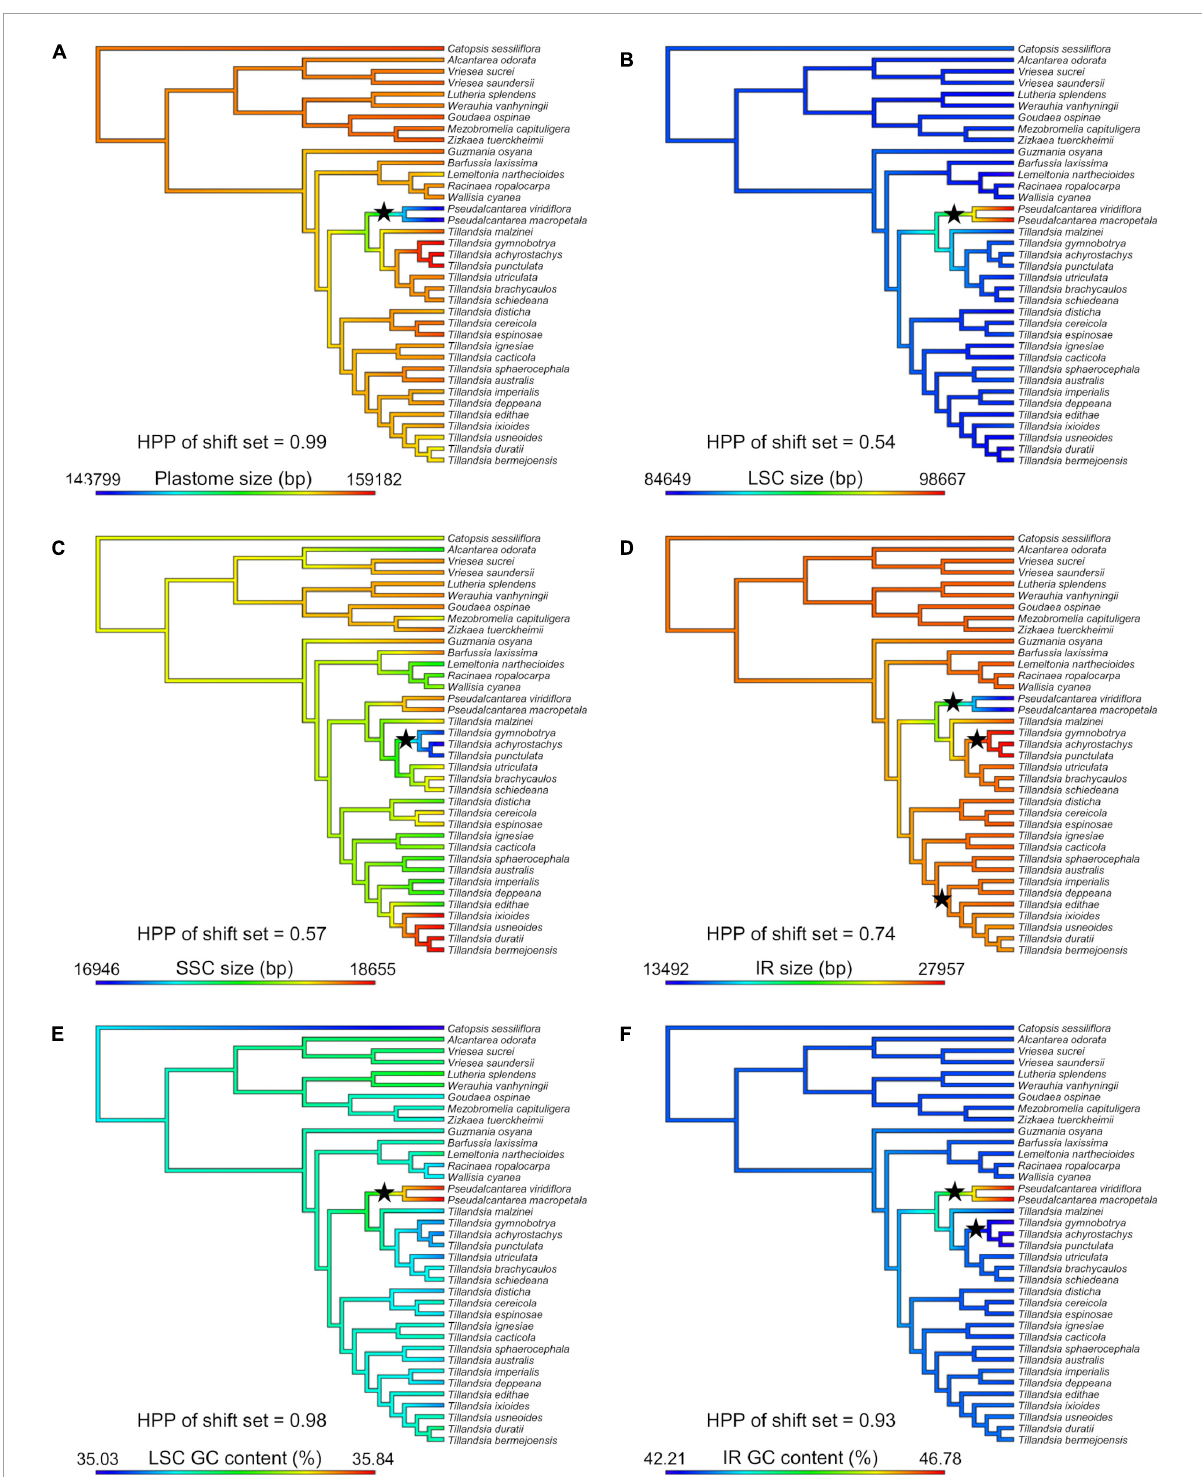
FIGURE3 Evolution of six plastome attributes where evolutionary rate shift sets were detected by BAMM with PP ≥ 0.5. Ancestral state reconstruction was inferred under a Maximum Likelihood (ML) framework and mapped on the Tillandsioideae phylogeny. (A) Plastome size. (B) LSC size. (C) SSC size. (D) IR size. (E) LSC GC content. (F) IR GC content. LSC, large single copy; SSC, small single copy; IR, inverted repeat; bp, base pairs; HPP, highest posterior probability. Black stars indicate the location of detected evolutionary rate